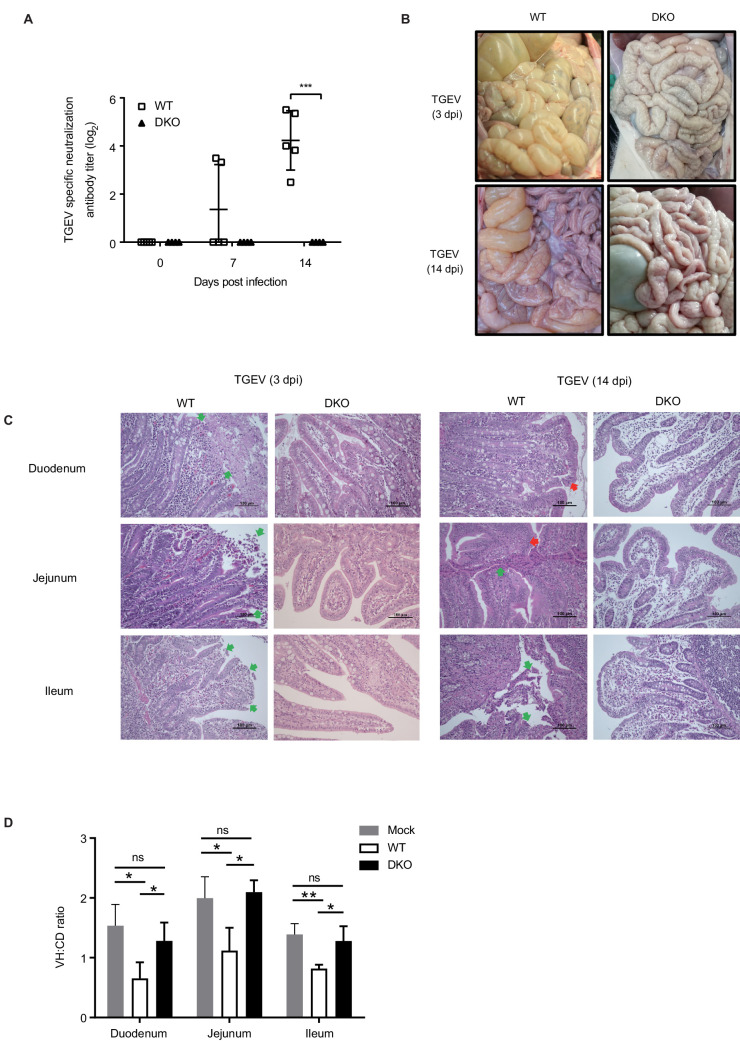
DKO pigs are resistant to TGEV infection.(A) TGEV-specific antibody detection in serum of WT and DKO pigs at 0, 7, and 14 dpi. WT group: N = 5; DKO group: N = 4. (B) Representative macroscopic lesion of small intestines at 3 dpi (top) and 14 dpi (bottom) in WT and DKO pigs. (C) H and E staining of lesions small intestine sections derived from both WT and DKO pigs at 3 dpi (left) and 14 dpi (right). H and E staining shows intestinal villi fusion, plasma cells accumulating in the lamina propria, and infiltration of eosinophils (red arrow), and necrosis and shedding of intestinal mucosal epithelial cells (green arrow). (D) The ratio of intestinal villus height to the crypt depth derived from both WT and DKO pigs at 3 dpi. Mock: duodenum to ileum, N = 3. WT: duodenum to ileum, N = 3. DKO: duodenum, N = 4; jejunum, N = 3; ileum, N = 4. Data are expressed as the mean ± SD. Statistical significance was determined by Student’s t-test; ns, p>0.05; *p<0.05; **p<0.01; ***p<0.001.Figure 3—source data 1.TGEV-specific neutralization antibody in serum.Figure 3—source data 2.The ratio of intestinal villus height to the crypt depth in TGEV group.